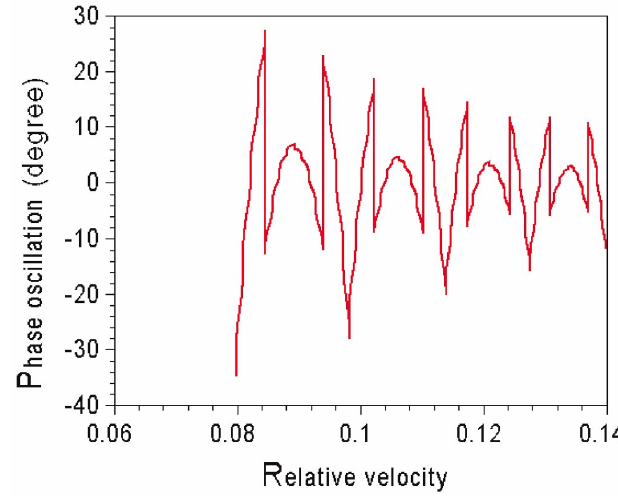
FIG. 18. (Color) Phase oscillation of the quasisynchronous par- ticle vs relative velocity for the second version of cavity-cavity